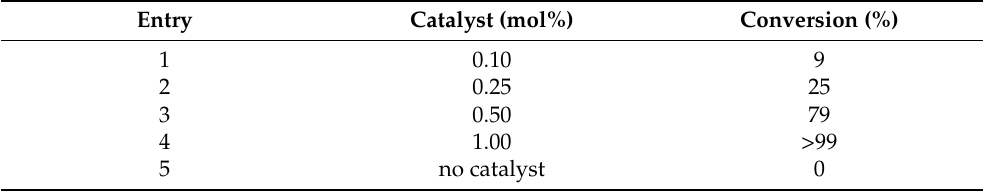
Table 2. Influence of the catalyst amount on the nitrobenzene-to-aniline hydrogenation. Reaction conditions: nitrobenzene (0.25 mmol), H 2 (40 bar), CoCorrPPh 3 @Vulcan-800 catalyst, MeOH (2 mL), 120 °C, 16 h, and n -hexadecane as internal standard (18 mg).